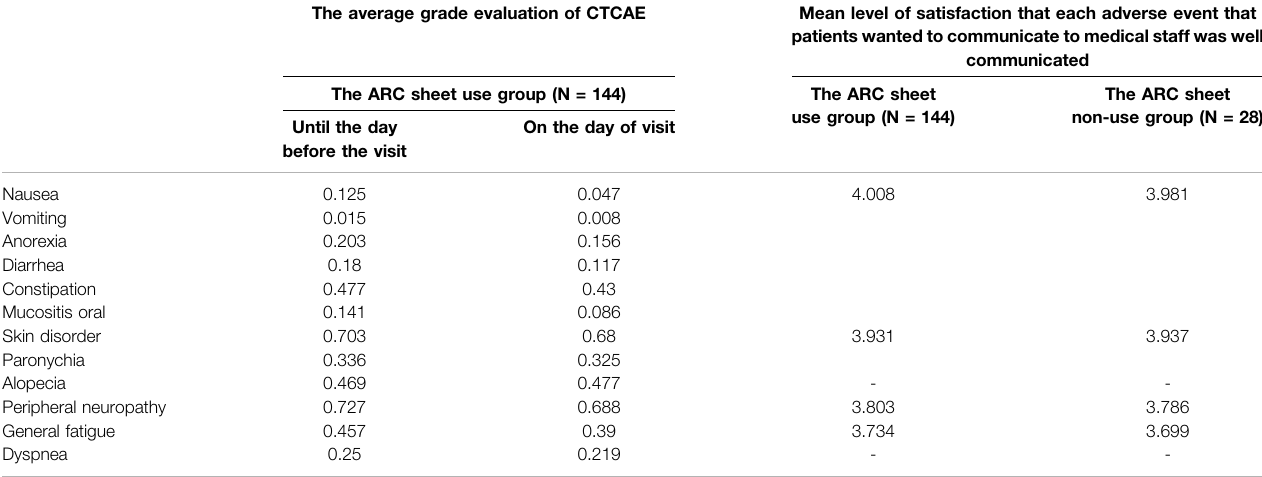
TABLE 2 | The evaluation of adverse events by CTCAE up to the day before and on the day of cancer drug therapy administration (left two rows)/The patient satisfaction ratings based on patient questionnaires for the ARC sheet use group and non-use group (right two rows). The average grade evaluation of CTCAE Mean level of satisfaction that each adverse event that patients wanted to communicate to medical staff was